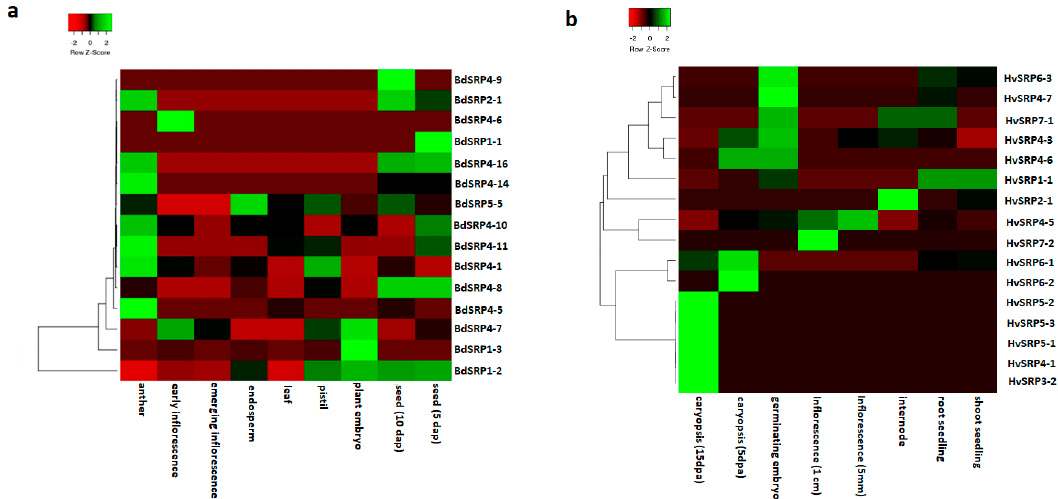
Figure 6. Expression patterns of Brachypodium (Bd21) and barley serpin genes in various tissues / organs and developmental stages. Hierarchical clustering analysis of 15 BdSRP genes ( a ) and 16 HvSRP genes ( b ) were based on Pearson’s correlation.